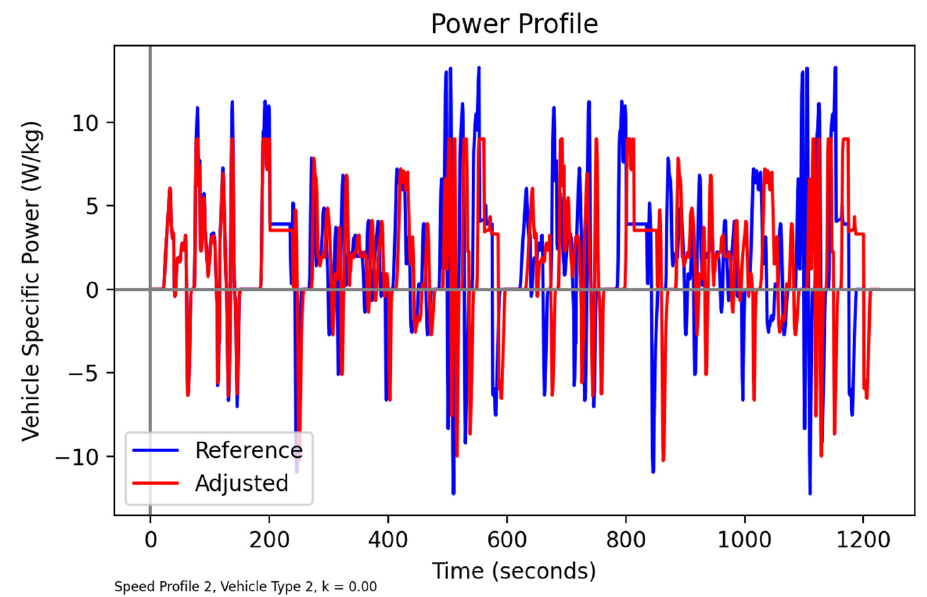
Figure 8. Vehicle Specific Power profile for adjusted and reference speed profiles (WMTC Reference Cycle 2, Vehicle Type 2, Flat terrain assumed in adjustment).